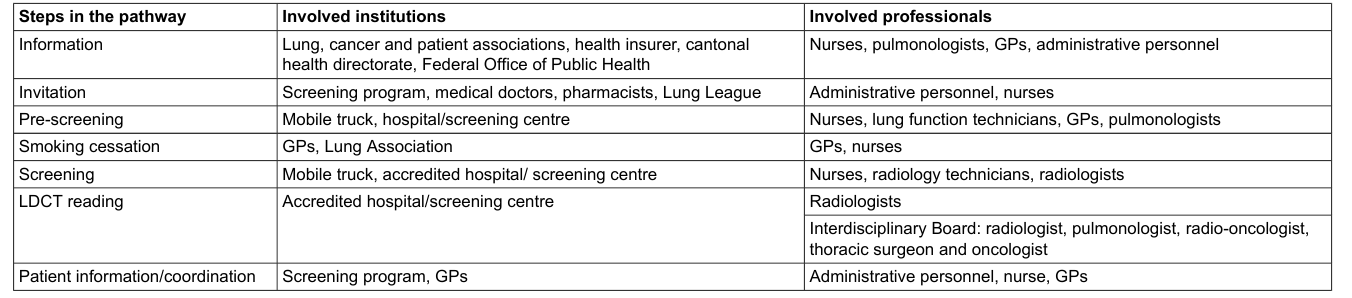
Table 3: Prospective institutions and their role. Steps in the